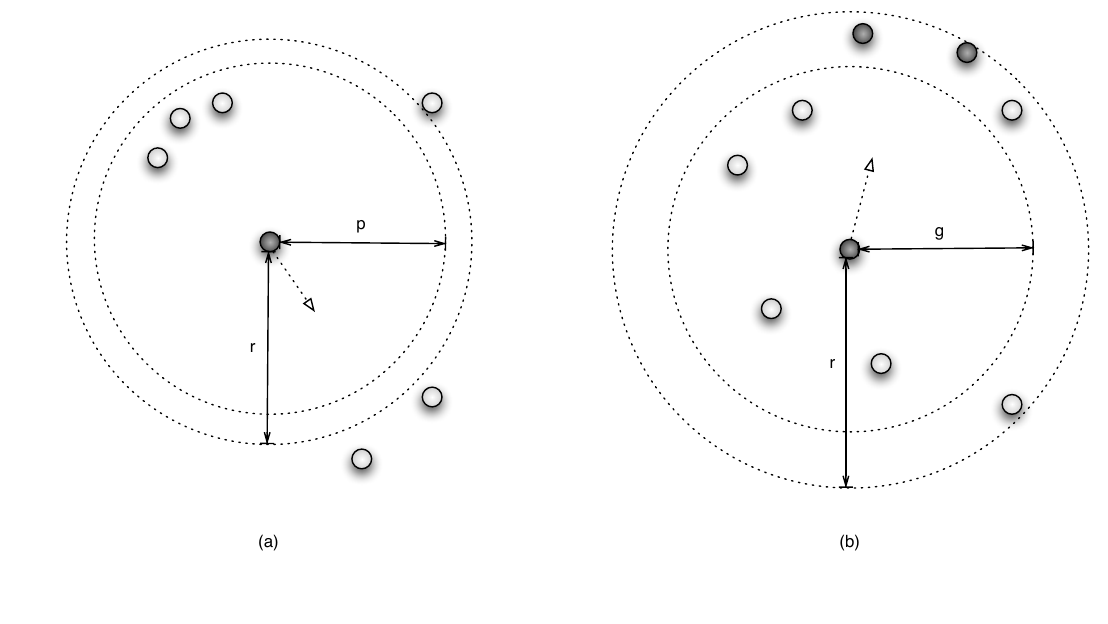
Figure 4. Basic behavioural rules: a basic proxemic rule drives an agent to move away from other agents that entered/are present in his/her own personal space (delimited by the proxemic distance p ) ( a ), whereas a member of a group will pursue members of his/her group that have moved/are located beyond a certain distance ( g ) but within his/her perception radius ( r ) ( b